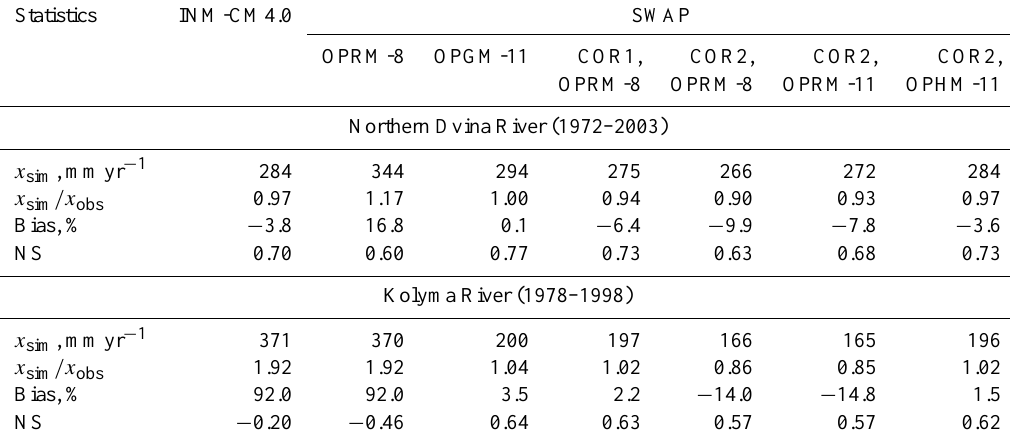
Table 1. Statistical characteristics of river runoff simulations ( x sim ) performed by the LSM SWAP with different sets of optimal parameters and different bias-correction techniques and by the AOGCM INMCM4.0 (NS was calculated for monthly values).